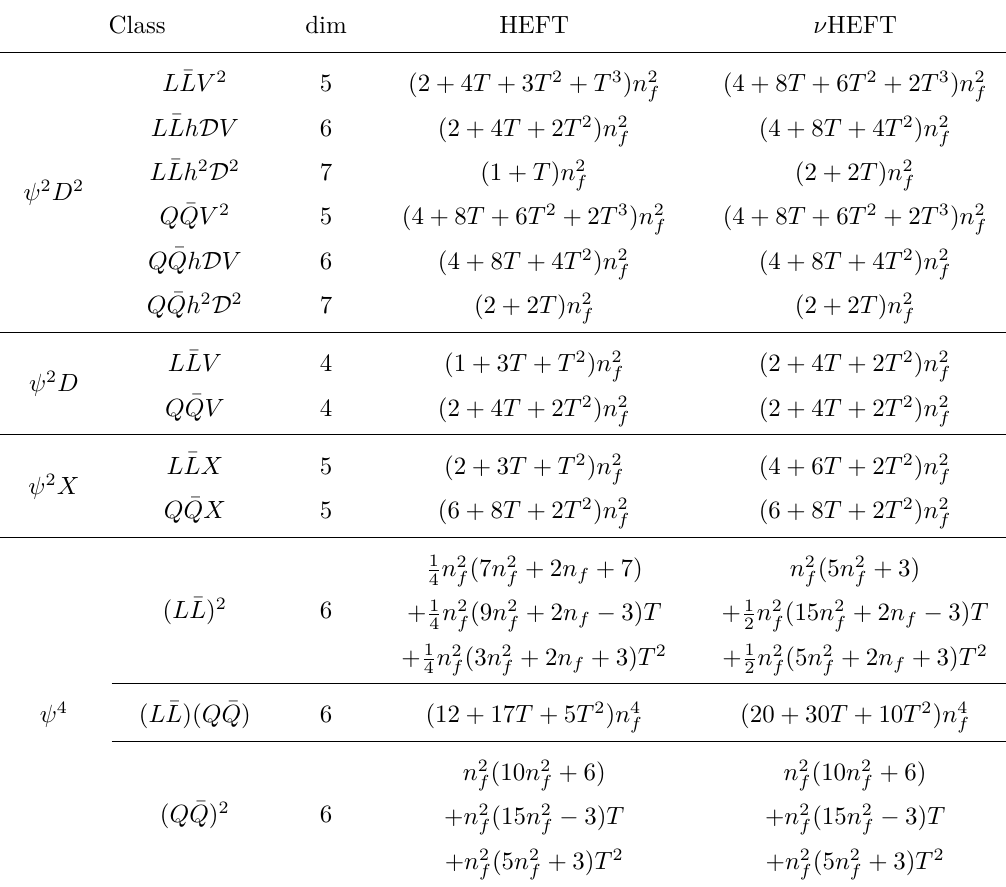
Table 7 . Spurion structure of the detailed breakdown of the eight classes of operators that are relevant for “NLO” ( ν )HEFT, fermionic sector conserving B and L